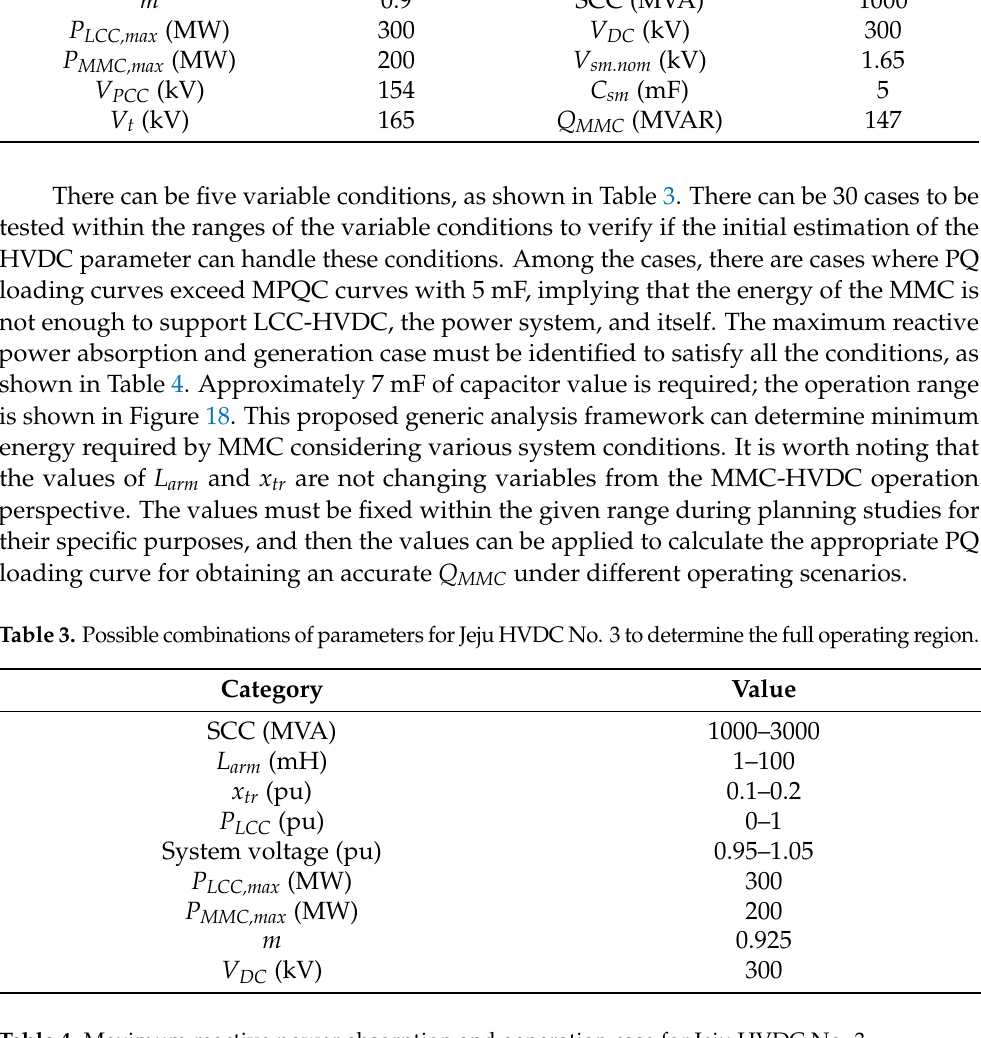
Table 4. Maximum reactive power absorption and generation case for Jeju HVDC No.